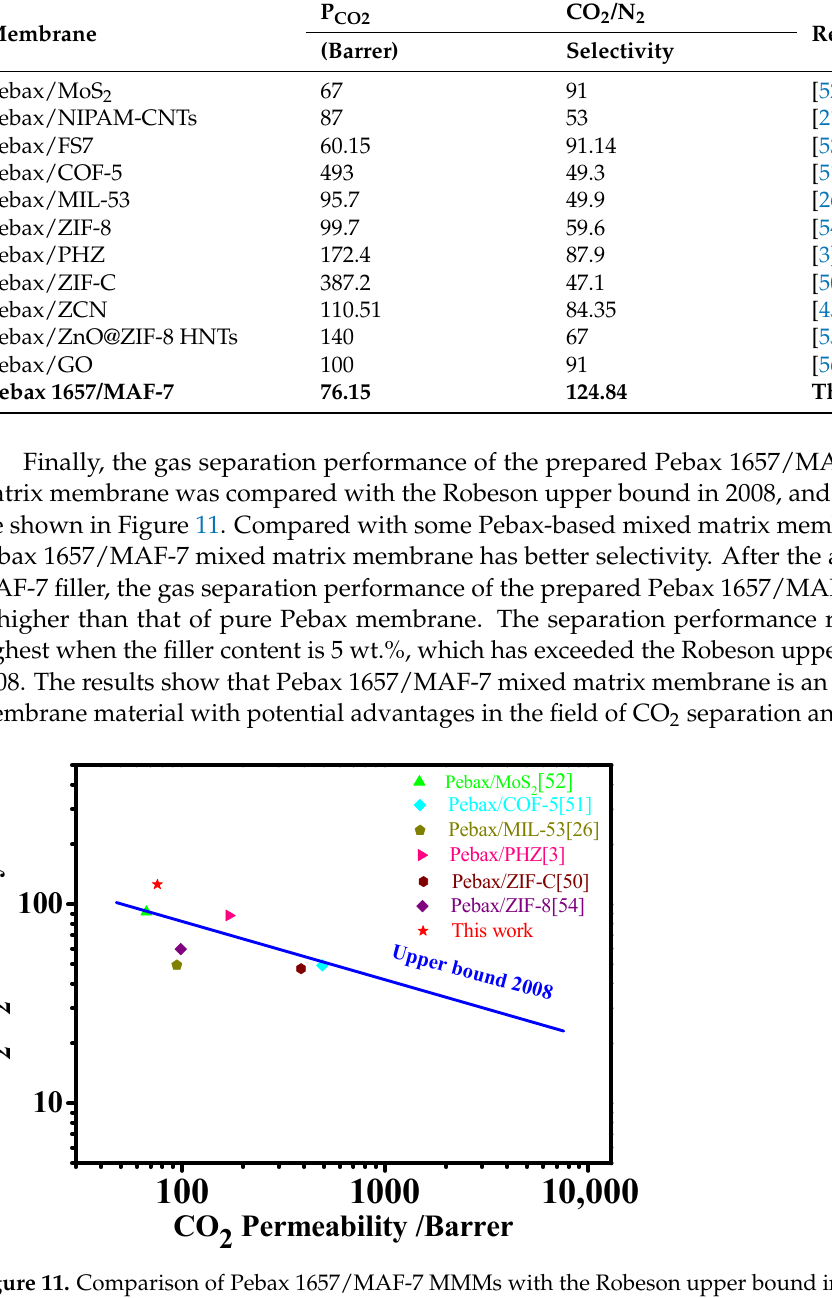
Figure 11. Comparison of Pebax 1657/MAF-7 MMMs with the Robeson upper bound in 2008.